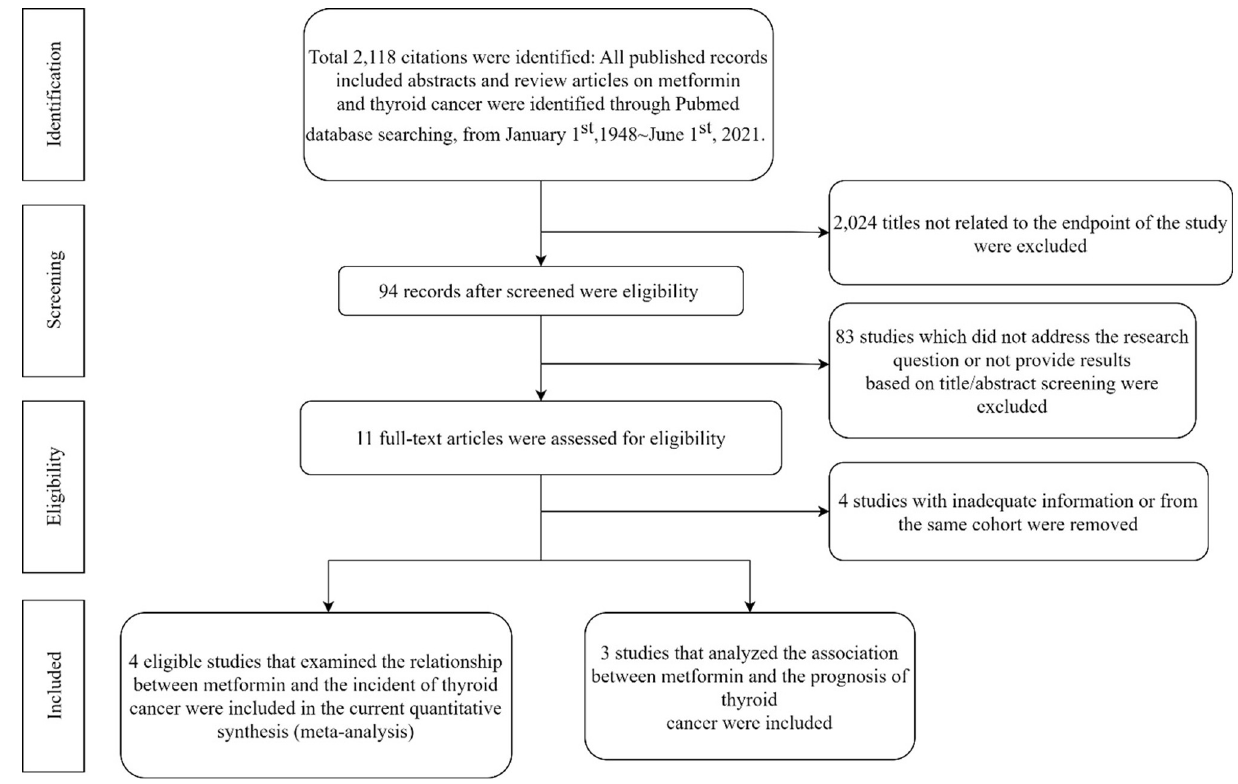
Fig 1. Flowchart of the study selection